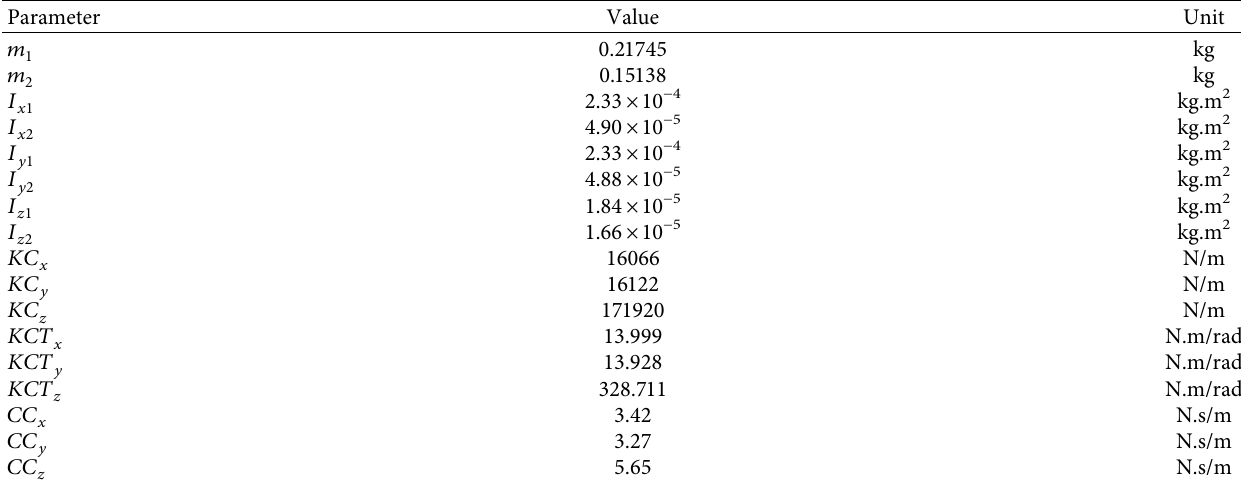
Table 5: Physical parameters of the white flexible coupling.